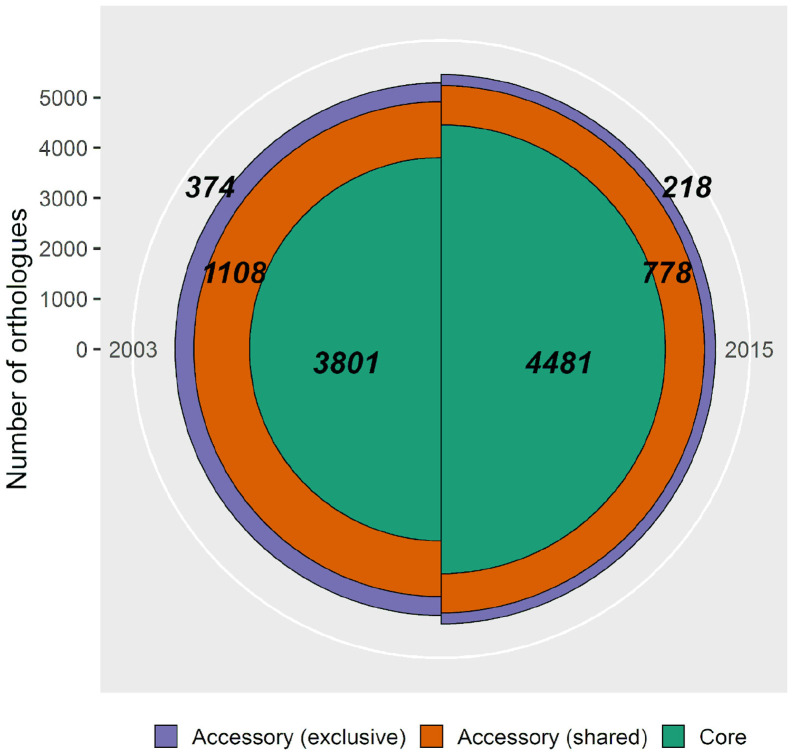
Pan-genomic comparison of Pseudomonas otitidis from 2003 and 2015 from Laguna Intermedia in the Churince system. The population from 2003 consists of 5 individuals and has a pan-genome of 5,283 genes and the one from 2015 consists of 7 individuals with a pan-genome of 5,477 genes. The green (innermost) fraction represents the core genome, the orange (middle) one the shared accessory genome and the purple one (outermost) the exclusive accessory genome of each sampling. Bold numbers indicate the quantity of genes in each category.